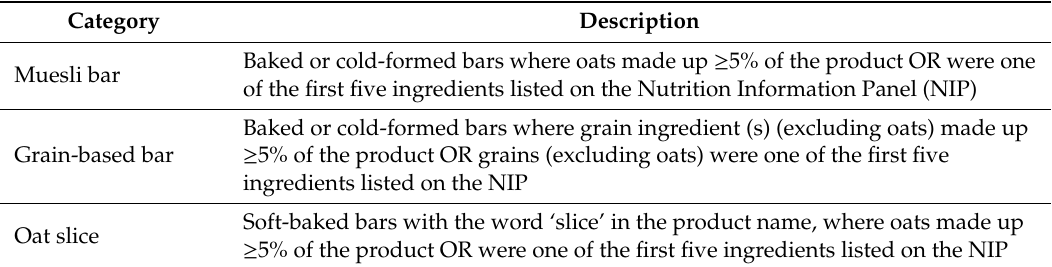
Table 1. Classification of